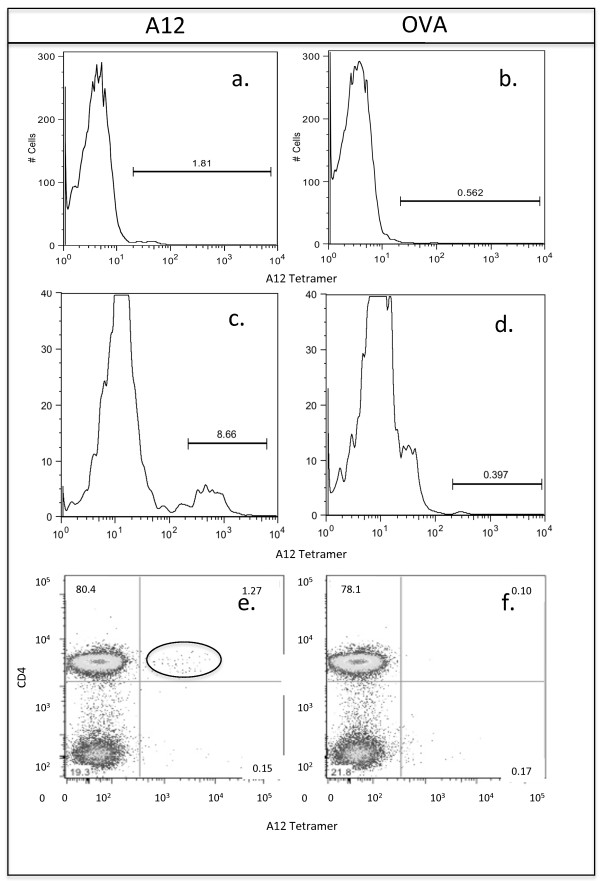
Ex vivo analysis of the development of the A12-specific T-cell response in DR1 Tg mice. DR1 mice were immunized with either A12 or OVA, and individual mice were killed on day 10 after immunization. Cells from inguinal lymph nodes were collected and either analyzed immediately (a, b) or stimulated for 4 days with the A12 peptide or Ova before analysis (c, d). (Lower panel) DR1 mice were immunized with either CII/CFA (e) or Ova (f) and, at the time of onset of arthritis, were treated subcutaneously (100 μg/mouse in IFA) with either A12 peptide (e) or Ova (right) (f). Cells were collected from inguinal lymph nodes on day 26 after treatment with peptide, and the cells were analyzed for the presence of tetramer-positive cells directly ex vivo with flow cytometry. All cells were analyzed for the presence of A12-specific T cells by using the DR1-A12 tetramer and anti-CD3 or anti-CD4, anti-CD8, and anti-CD19. Anti-CD8 and anti-CD19 were used simultaneously in the FL4 channel, and anti-CD3 or anti-CD4 was used in the FL1 channel. The cells represented are CD19-/CD8-/CD3+ or CD19-/CD8-/CD4+. Data are representative of at least six mice per time point and are based on a minimum of 100,000 cells analyzed.